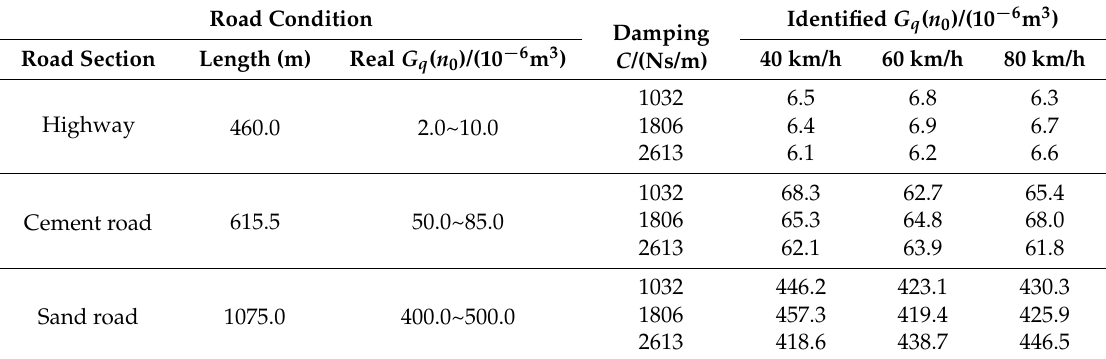
Table 2. The identified PSD G q ( n 0 ) values.